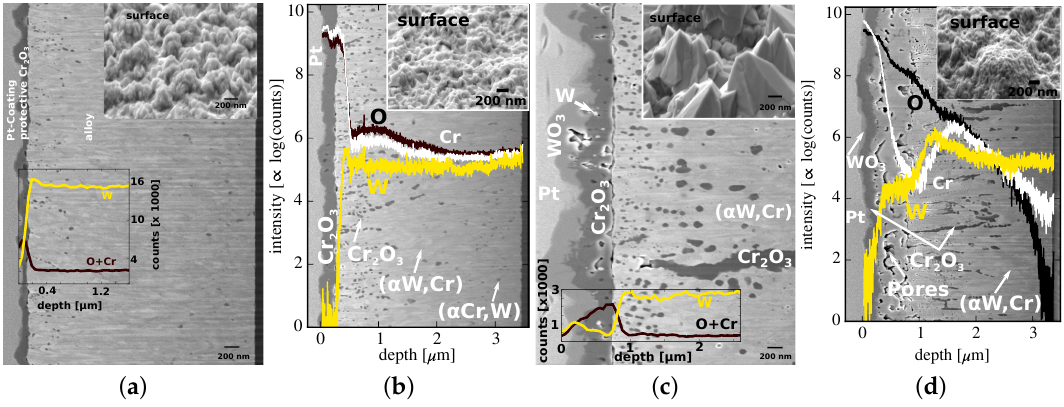
Figure 4. Electron microscopy images of cross sections and surface images in the inset. The ternary W-12Cr-0.5Y alloy is shown in ( a – c ), whereas ( d ) is the binary W-11Cr alloy. They are exposed to a temperature of 1273K at 20kPa O 2 and 80kPa Ar partial pressure: ( a ) for 10min; ( b ) for 75min; ( c ) for 8h; ( d ) for 15min. In ( b , d ) the corresponding SIMS profile and in ( a , c ) the corresponding EDX-line scans in the region of the box are overlaid with the electron